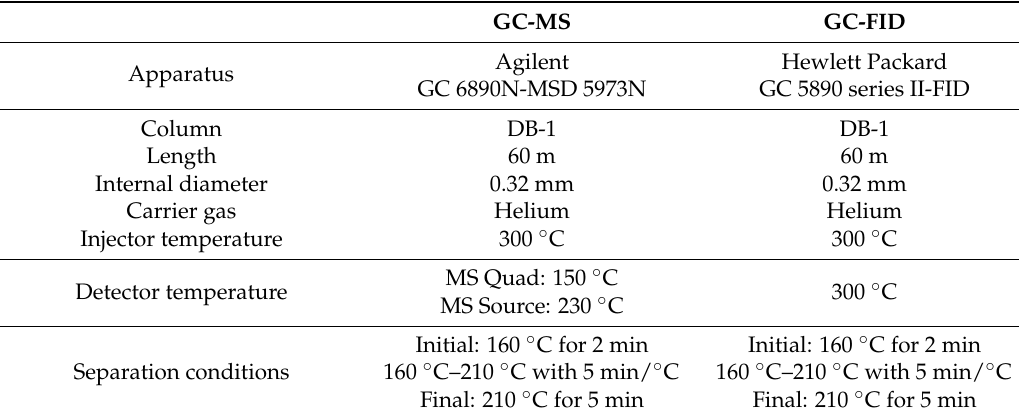
Table 4. Analysis parameters of GC-MS and